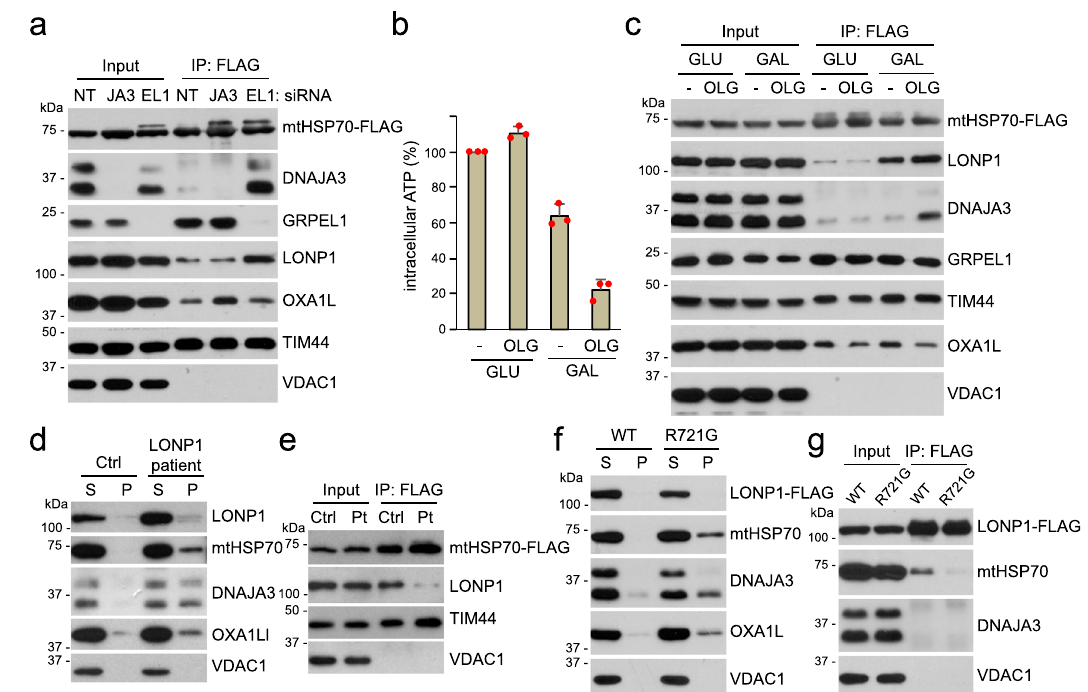
Fig. 4 Co-immunoprecipitation of LONP1 and mtHSP70. a Physical interactions of mtHSP70-FLAG upon DNAJA3 (JA3) or GRPEL1 (EL1) knockdown. mtHSP70-FLAG was constitutively expressed, immunoprecipitated and analyzed by Western blotting. NT: non-target. b Quanti fi cation of intracellular ATP after glucose (GLU) or galactose (GAL) culture in the absence or presence of 5 μ M oligomycin (OLG) for 2 h. Red dots indicate individual data points ( n = 3 independent experiments). Data are presented as means ± standard deviation. c Effect of galactose culture and oligomycin treatment on mtHSP70 interactions. Immunoprecipitates of mtHSP70-FLAG were analyzed for the indicated proteins. d Mitochondrial protein solubility in control (Ctrl) and LONP1 patient (bi-allelic p.Tyr565His and p.Glu733Lys variants) fi broblasts. e mtHSP70 interactions in control (Ctrl) and LONP1 patient (Pt) fi broblast cells. mtHSP70-FLAG was expressed in the indicated cells and immunoprecipitated. f Comparison of LONP1 WT and CODAS LONP1 R721G in rescuing mitochondrial protein aggregation in LONP1 knockdown cells. 143B cells expressing siRNA-resistant LONP1 WT and CODAS LONP1 R721G were treated with siRNA against LONP1 and analyzed by Triton X-100 extraction. g Comparison of LONP1 WT and CODAS LONP1 R721G in interacting with mtHSP70. FLAG- tagged LONP1 WT and CODAS LONP1 R721G were expressed in 143B cells, and FLAG immunoprecipitates were analyzed for the indicated